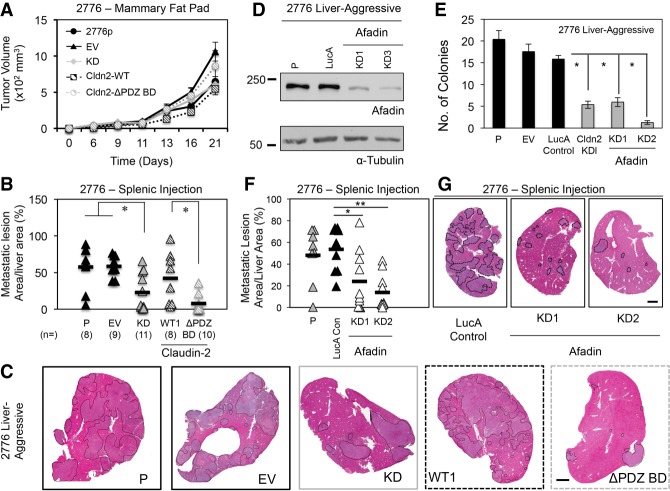
The Claudin-2 PDZ-binding motif and Afadin are required for efficient liver metastasis. (A) Tumor growth in the mammary fat pad was measured for the indicated liver-aggressive (2776) cell populations: parental (2776p), empty vector (EV), Claudin-2 shRNA expression vector (knockdown), a pooled population expressing wild-type Claudin-2, and a pooled population expressing a Claudin-2 mutant lacking three C-terminal amino acids (ΔPDZ BD). (B) Liver metastatic burden (tumor area per tissue area) was analyzed after splenic injection of the indicated cell lines. (*) P ≤ 0.005. The number of mice analyzed in each cohort is shown in parentheses. (C) Representative images of the cardiac liver lobe are shown. Metastatic lesions are indicated by dotted lines. Bar , 2 mm. (D) Afadin knockdown in liver-aggressive cells was assessed by immunoblot analysis, and α-Tubulin served as a loading control. (E) Colony formation in soft agar was assessed for the indicated cell populations. (*) P < 0.00001. (F) Liver metastatic burden (tumor area per tissue area) was analyzed following splenic injection for the indicated cell lines. (*) P < 0.008; (**) P < 0.0002. (G) Representative images of the cardiac liver lobe for each cell population are shown. Metastatic lesions are outlined by dotted lines. Bar, 2 mm.